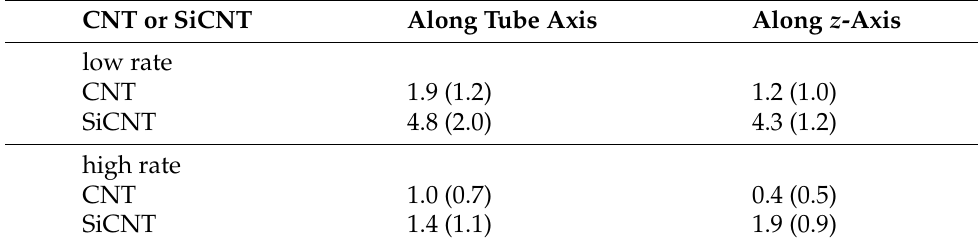
Table 2. Number of lipids removed during withdrawal.